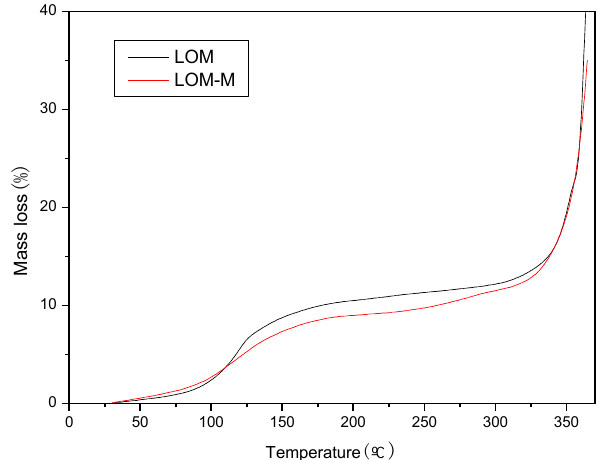
Figure 4. Thermogravimetric (TG) curves of lavender essential oil single-layered microcapsules (LOM) and double-layered microcapsules (LOM-M).